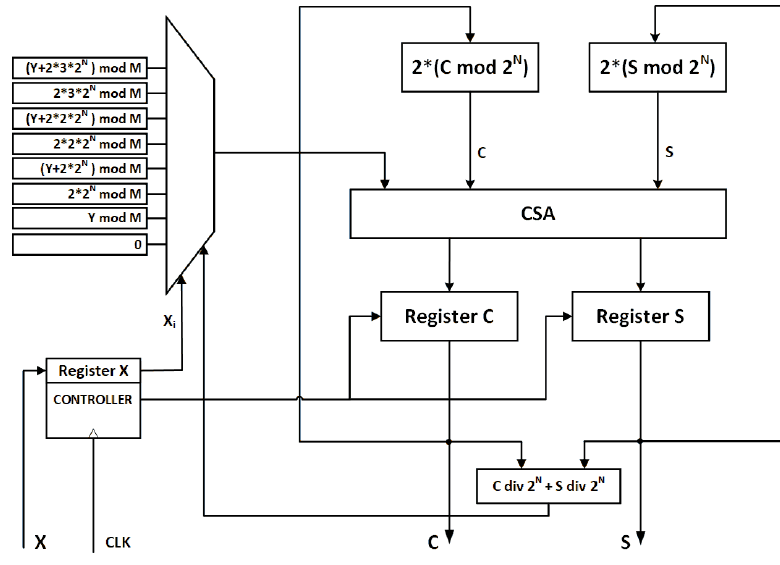
Figure 5. Basic Interleaved modular multiplication unit proposed by